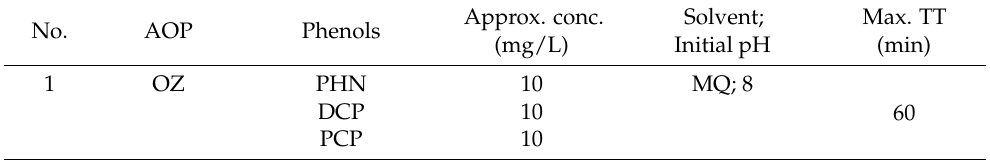
Table 1. List of test mixtures in ultrapure water (MQ) containing 10 or 50 mg/L phenol